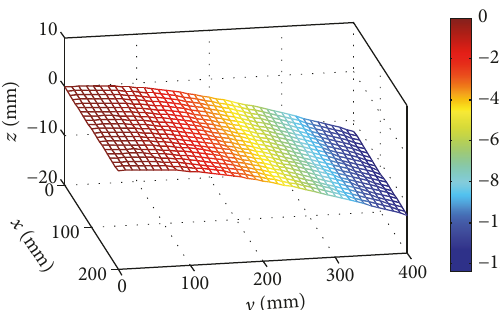
Figure 10: Controlled shape under optimal configuration.